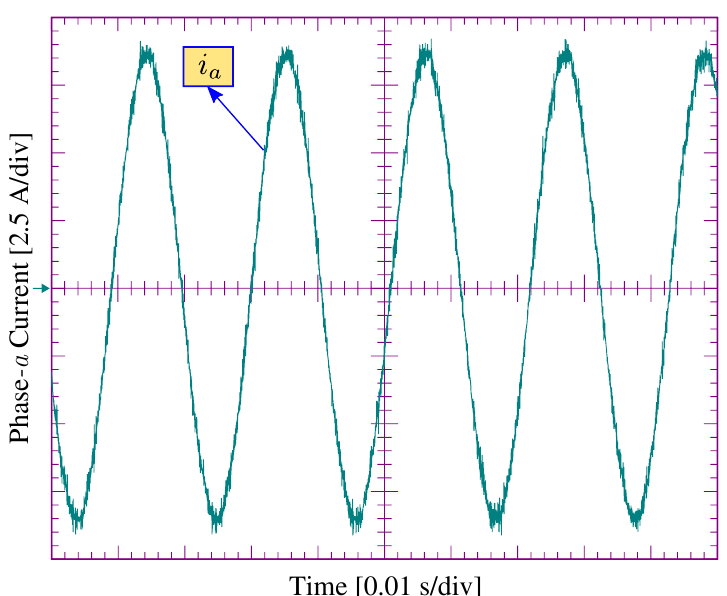
Figure 10. Phase a current at steady-state of the proposed zero angle LFS injection based PMSM drive with FSTP inverter. Operating at: 0.25 pu d -axis voltage and zero q -axis voltage with 10 kHz switching frequency under fan type loading condition.